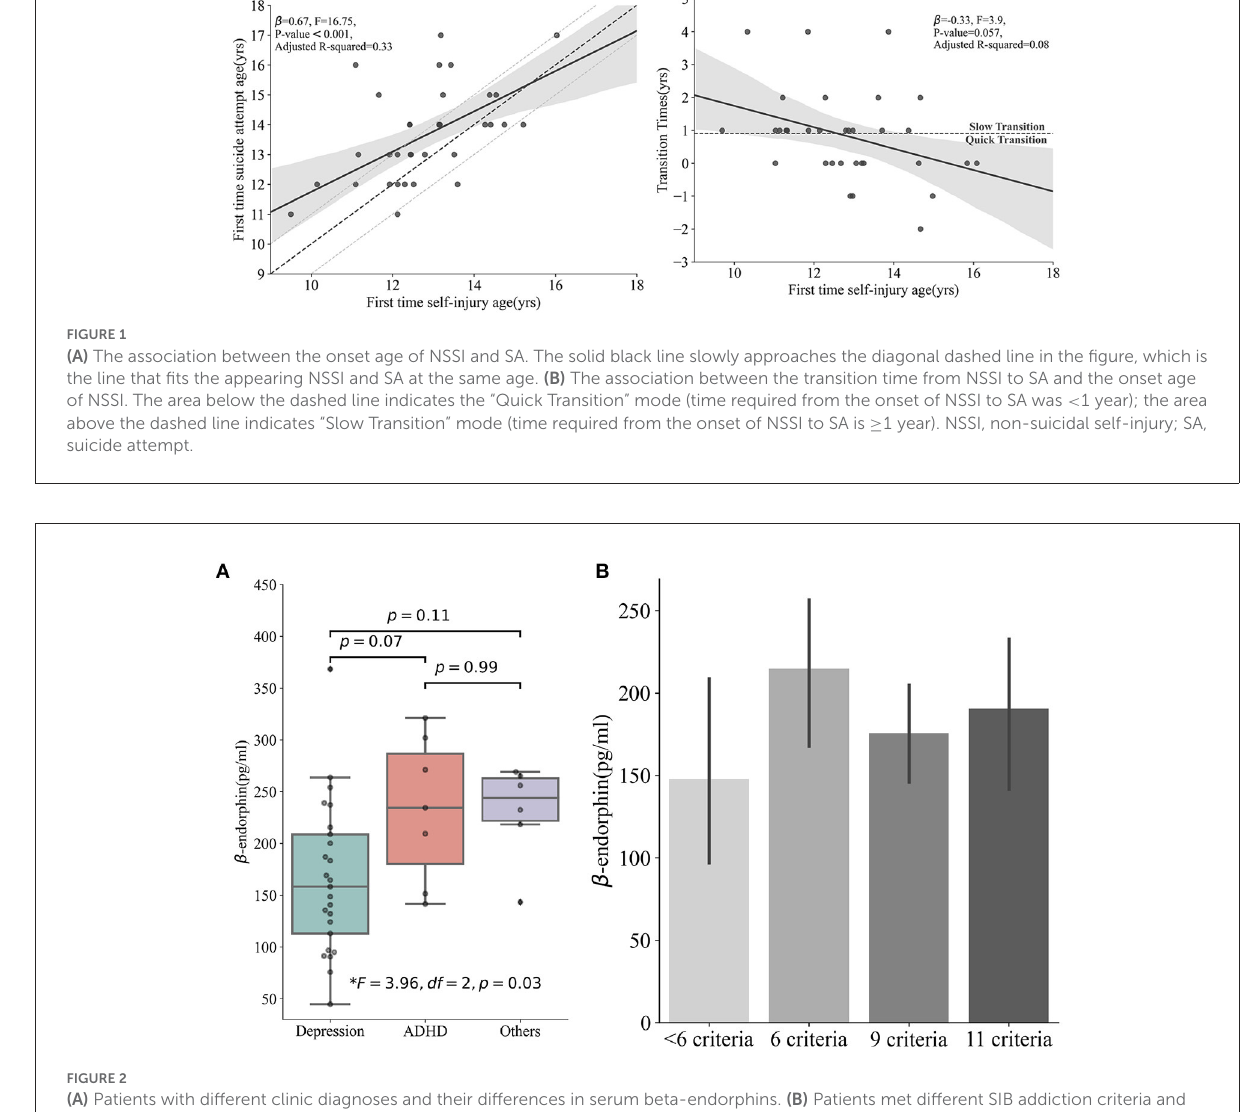
of SA (see Figure 1B). Based on this feature, we propose a classification: (1) the “Quick Transition” group: patients who began SA within 1 year after their first NSSI episode or who began their SIB career with a suicide attempt; and (2) the “Slow Transition” group: patients who passed more than 1 year between their first NSSI episode and their first SA. In addition, the “Unknown” group was comprised of patients who had begun NSSI < 1 year before our data collection and had no SA. No difference was found between the quick transition group and the slow transition group (194.42 ± 83.77 vs. 187.96 ± 69.23, p = 0.81).